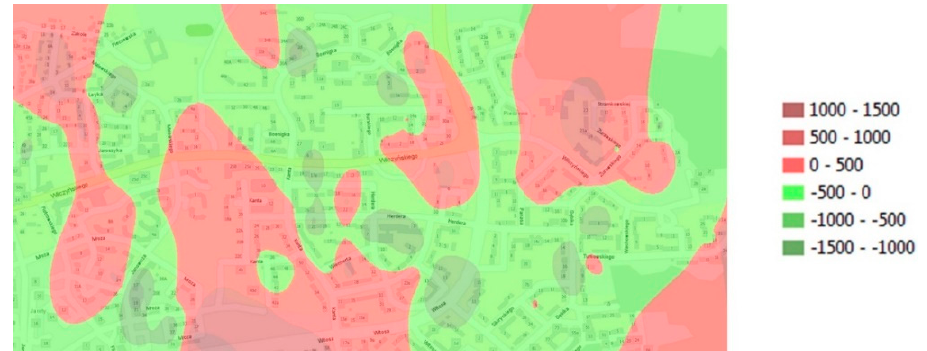
Figure 9. A differential diagram for average prices in 2014, generated based on a GRID structure with 0.0001° resolution. Source: own elaboration.